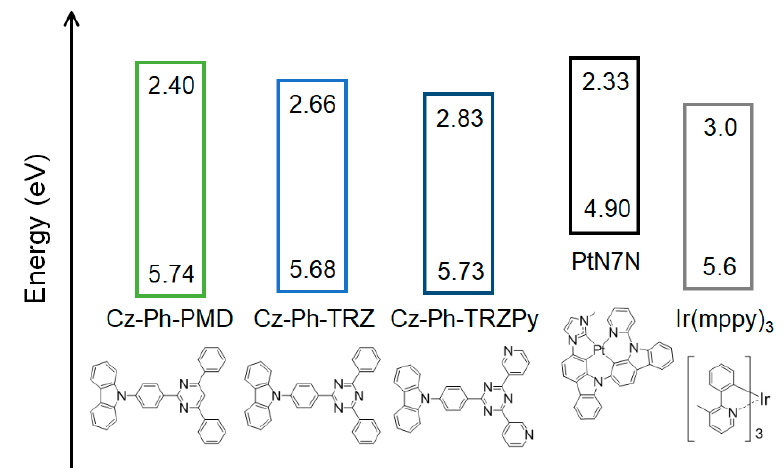
Figure 4. Molecular structures and energy levels of the host materials and emitters.